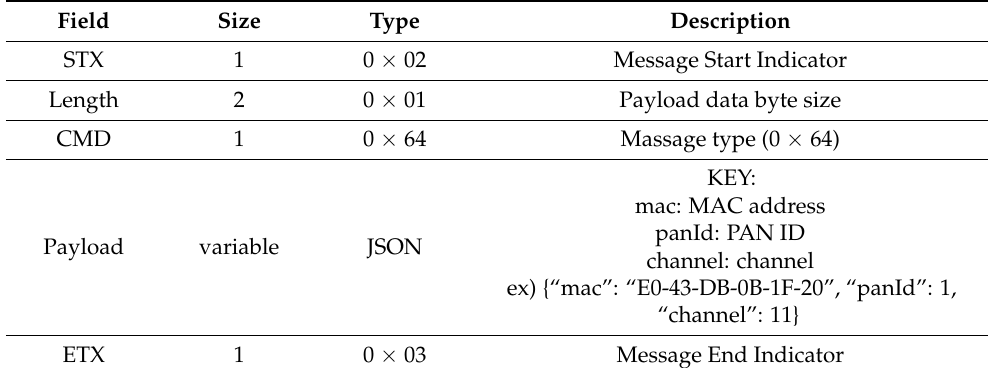
Table 11. Communication protocol for gateway registration.